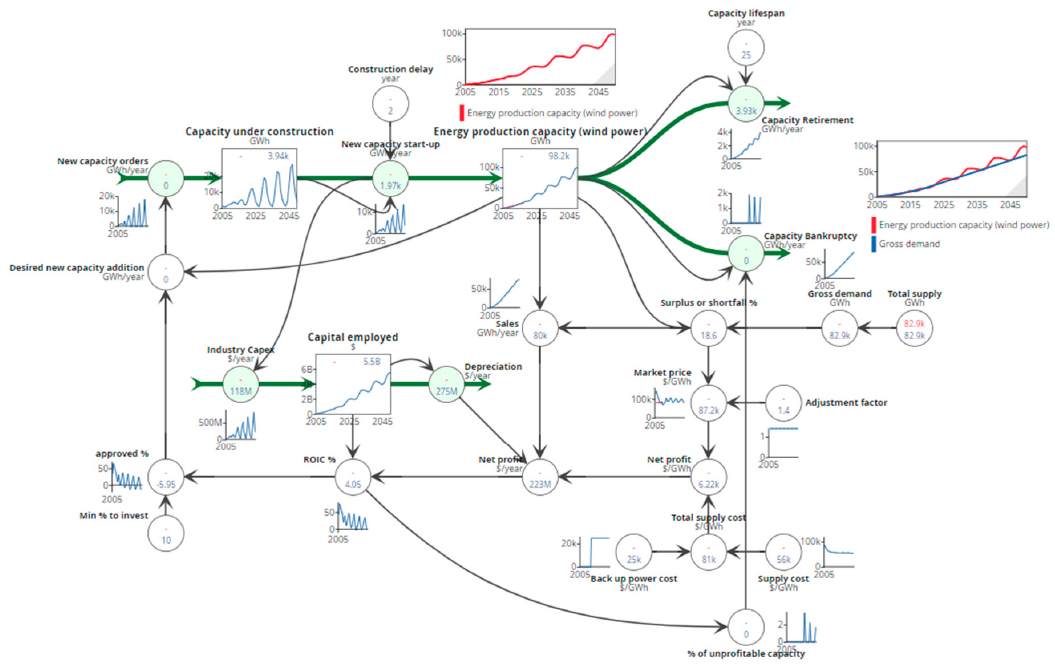
Figure 4. Energy resources extraction pipeline model for non-dispatchable resources.